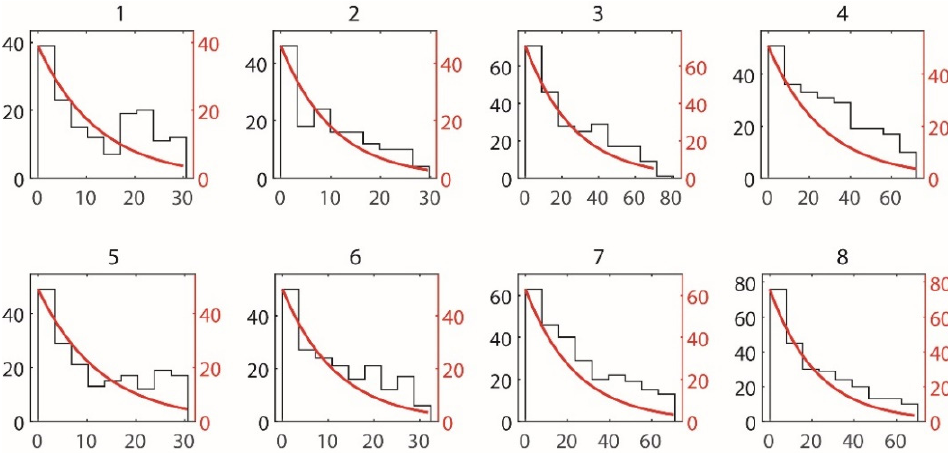
Figure 4. Frequency distribution of hit depth for different combinations of variable levels.